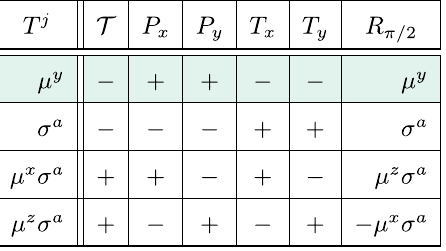
¯ XT j X FIG. 3. How tr ð σ a Þ transform under the physical symmetries. T j ¼ f μ y ; σ a ; μ x σ a ; μ z σ a g are the ten generators of